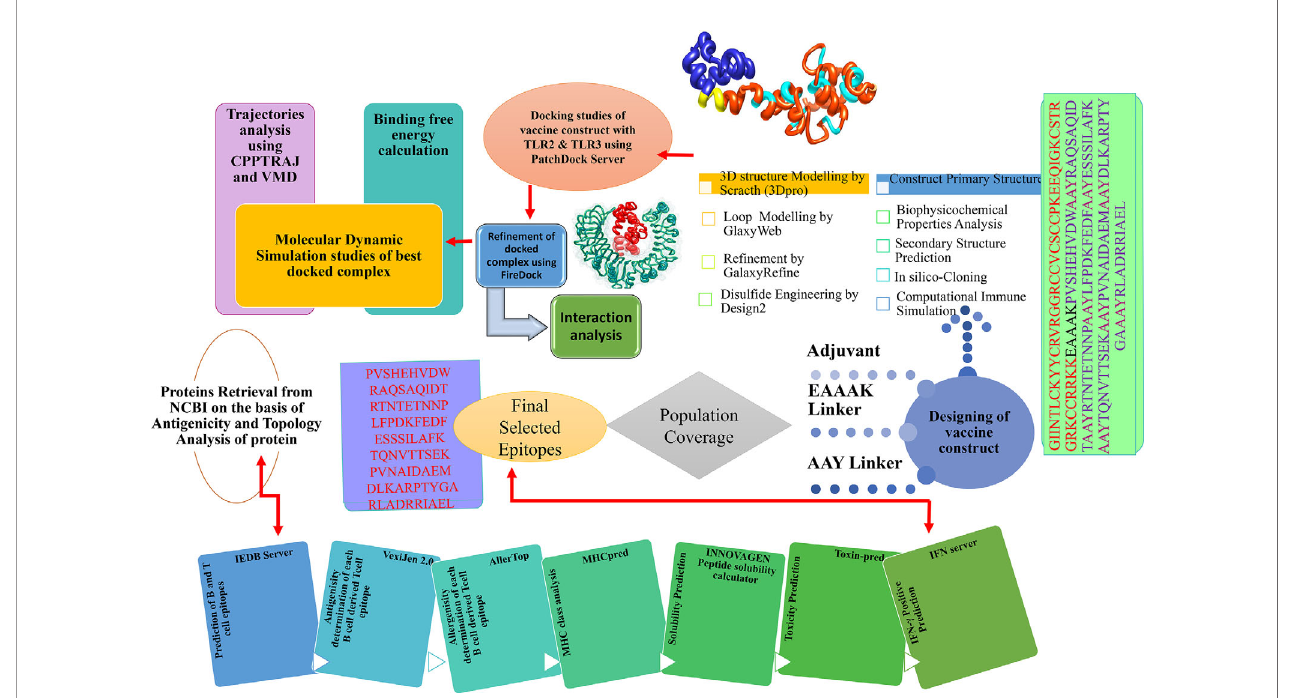
FIGURE 1 | In silico approaches implemented to design vaccine construct against CCHFV. Multi-Epitopes Vaccine